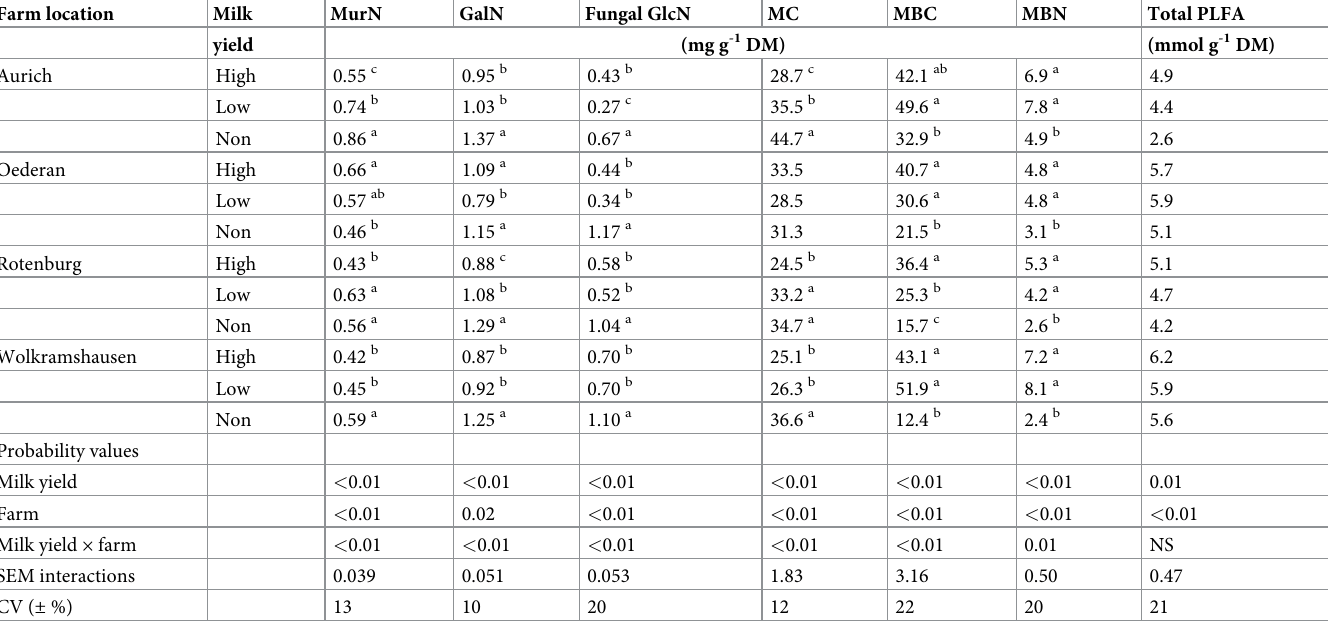
Table 3. Mean contents of muramic acid (MurN), galactosamine (GalN), fungal glucosamine (GlcN), microbial C (MC), microbial biomass C (MBC) and N (MBN), and total phospholipid fatty acids (PLFA) in the cow faeces, broken down according to the four farms and the three milk yield groups. Farm